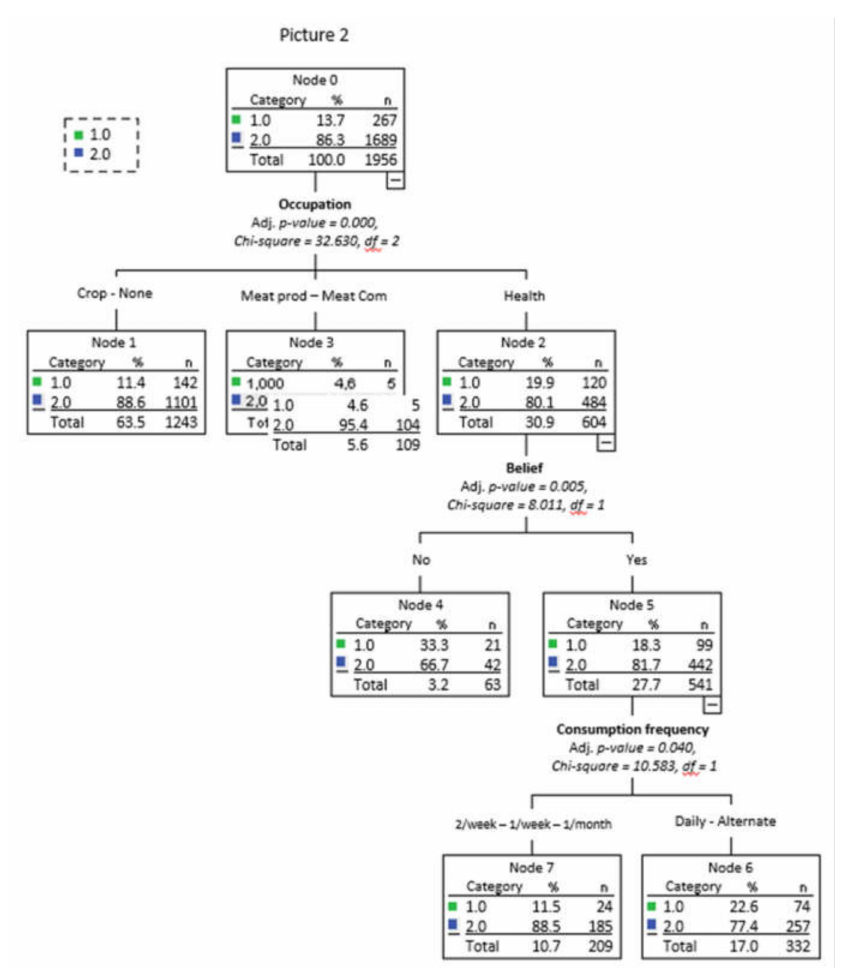
Figure 4. Decision tree for Picture 2 as a function of socio-demographic variables, purchase habits, beliefs and criteria used in the